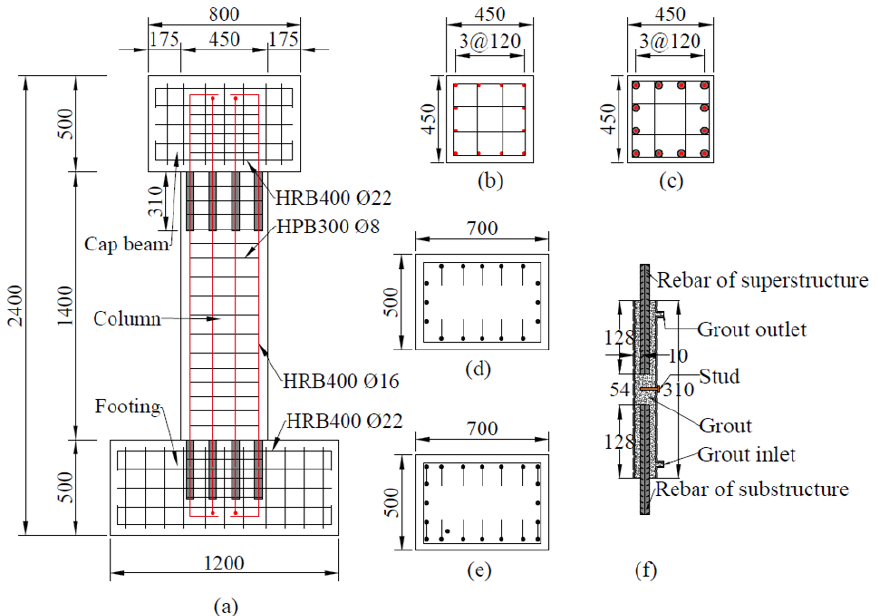
Figure 1. Details of the specimen: ( a ) precast column with grouted sleeve connections; ( b ) cross section of the column; ( c ) cross section of the column with grouted sleeve connections; ( d ) cross section of the cap beam; ( e ) cross section of the footing; ( f ) details of the grouted sleeve.